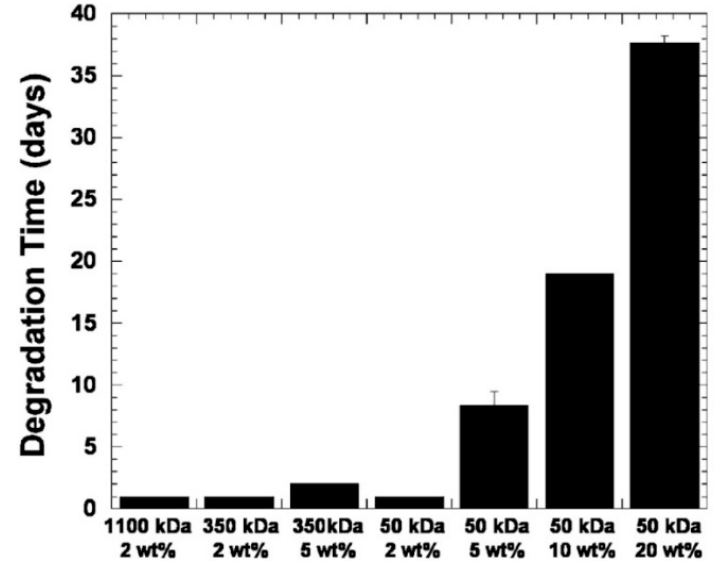
Figure 24. Time of complete degradation of MeHA-based hydrogels in a solution of 100 U / mL hyaluronidase in PBS. Reproduced from [135], with permission from American Chemical Society, 2020. Time of complete degradation of hydrogel composed of 350 kDa HA, 5 wt.% was less than for hydrogel composed of 50 kDa HA, 5 wt.%. The authors note the correlation between the degradation time and the swelling ratio. This is true for hydrogels obtained from HA samples of the same molecular weight with di ff erent concentrations, although the swelling ratio of hydrogels with di ff erent molecular weights but the same concentration di ff ered